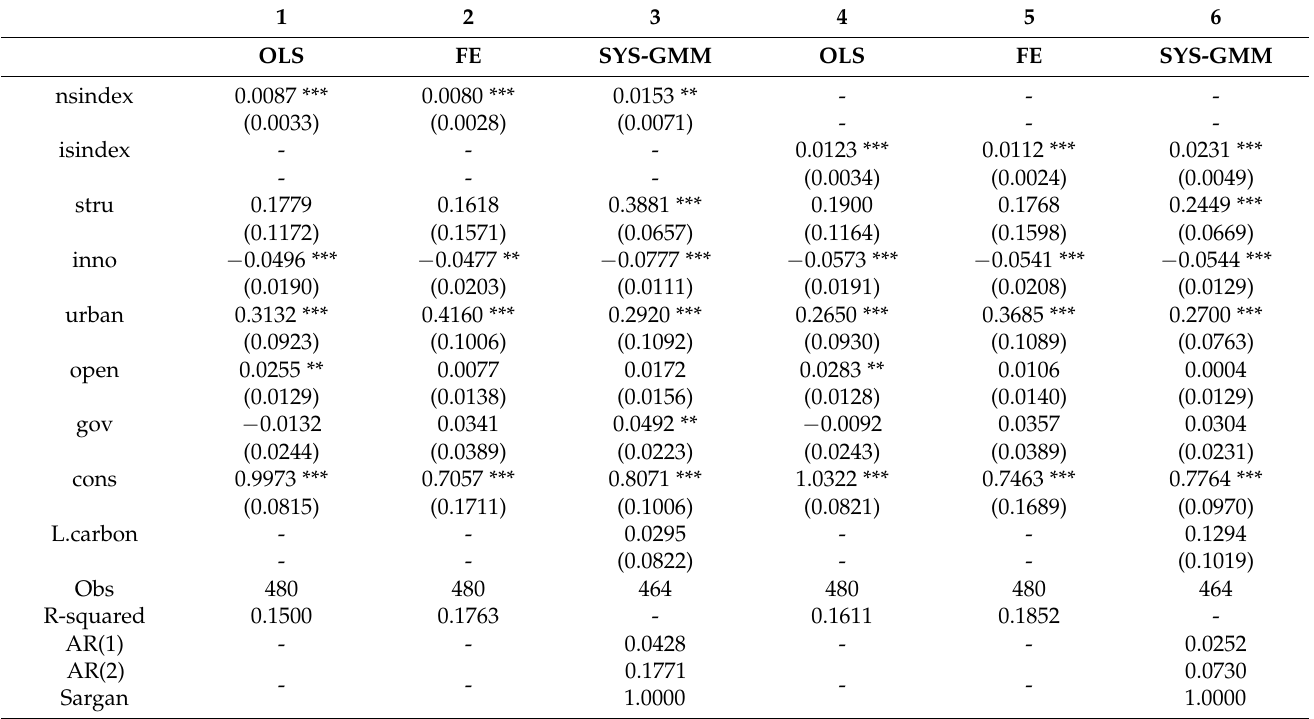
Table 2. Benchmark regression